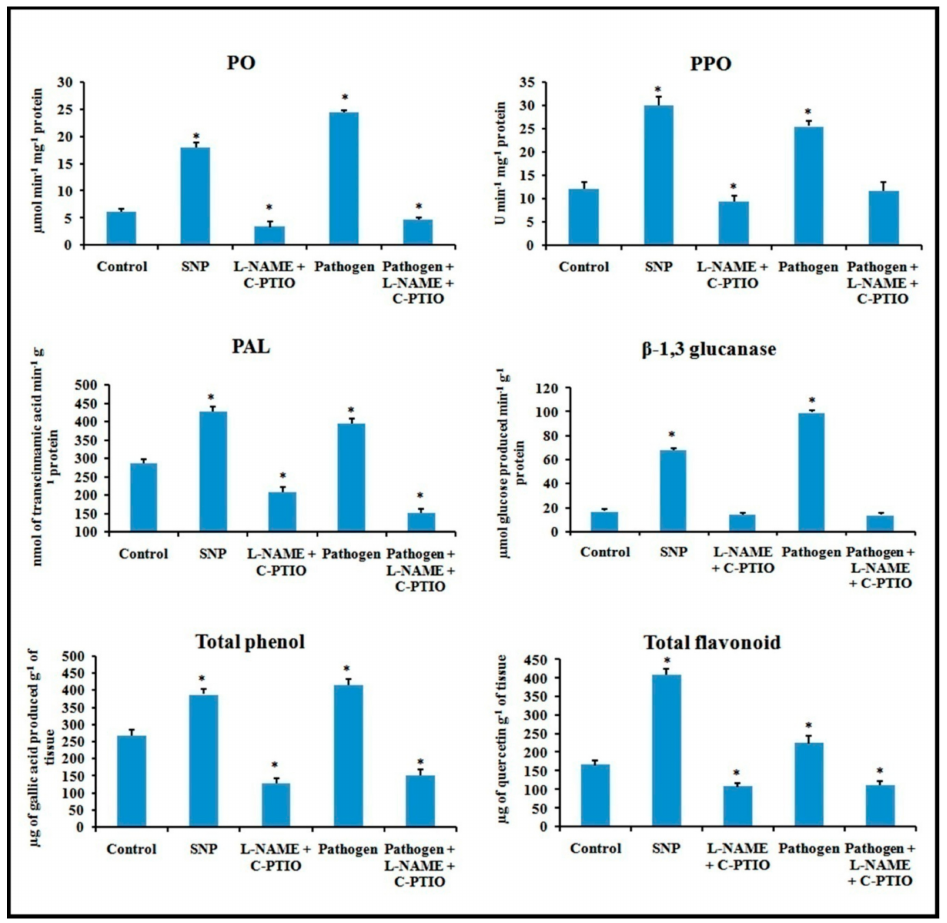
Figure 14. E ff ect of NO modulators on the production of defense enzymes, phenols, and flavonoids in detached bean leaf. Values represent mean ± SD of three separate experiments, each in triplicate. * Significant di ff erence between pathogen-inoculated and control sets at P < 0.05